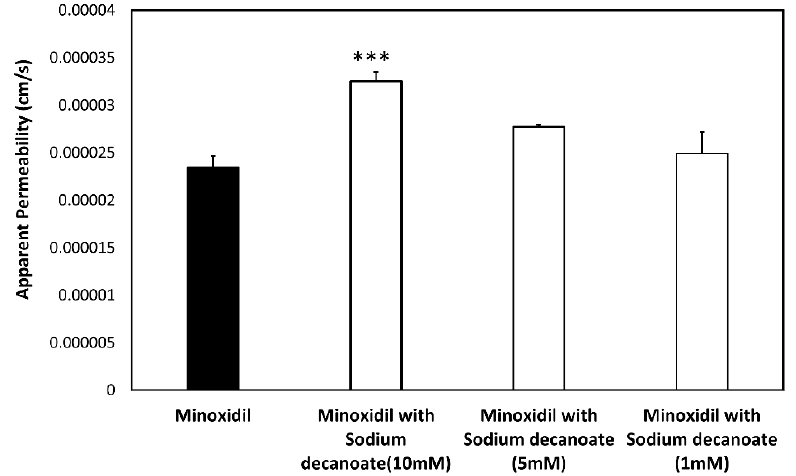
Figure 4. The permeability values of minoxidil alone and minoxidil with sodium decanoate in different concentration across Caco-2 cell monolayers. Mean ± SD; n = 4, *** p -value < 0.001.